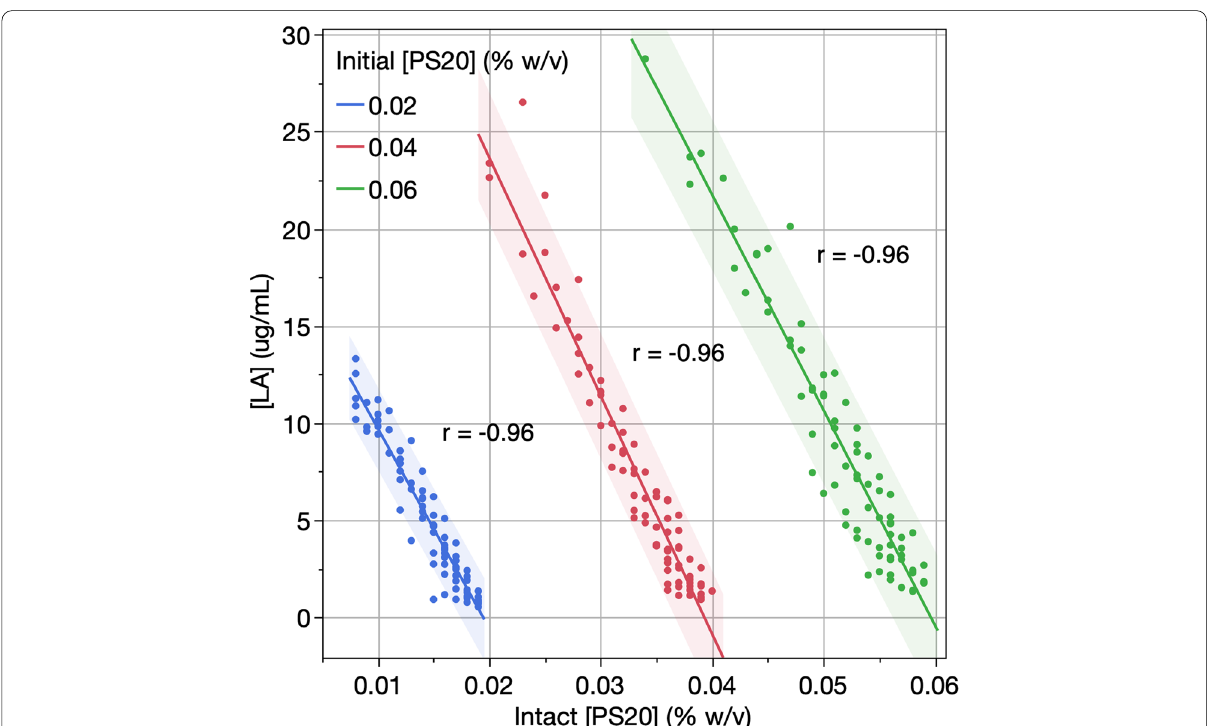
Fig. 10 Correlations between [LA] and intact [PS20] for mAb X DP stored at 5 °C. The 24 formulations (listed in Table 1) represent unique combinations of [mAb], initial [PS20], and pH. [LA] was quantified by LC–MS; intact [PS20] was quantified by HPLC‑ELSD. Correlation coefficient ( r ) values for formulations with the same initial [PS20] are shown within the plot. Shaded areas represent 95% prediction intervals of the fitted